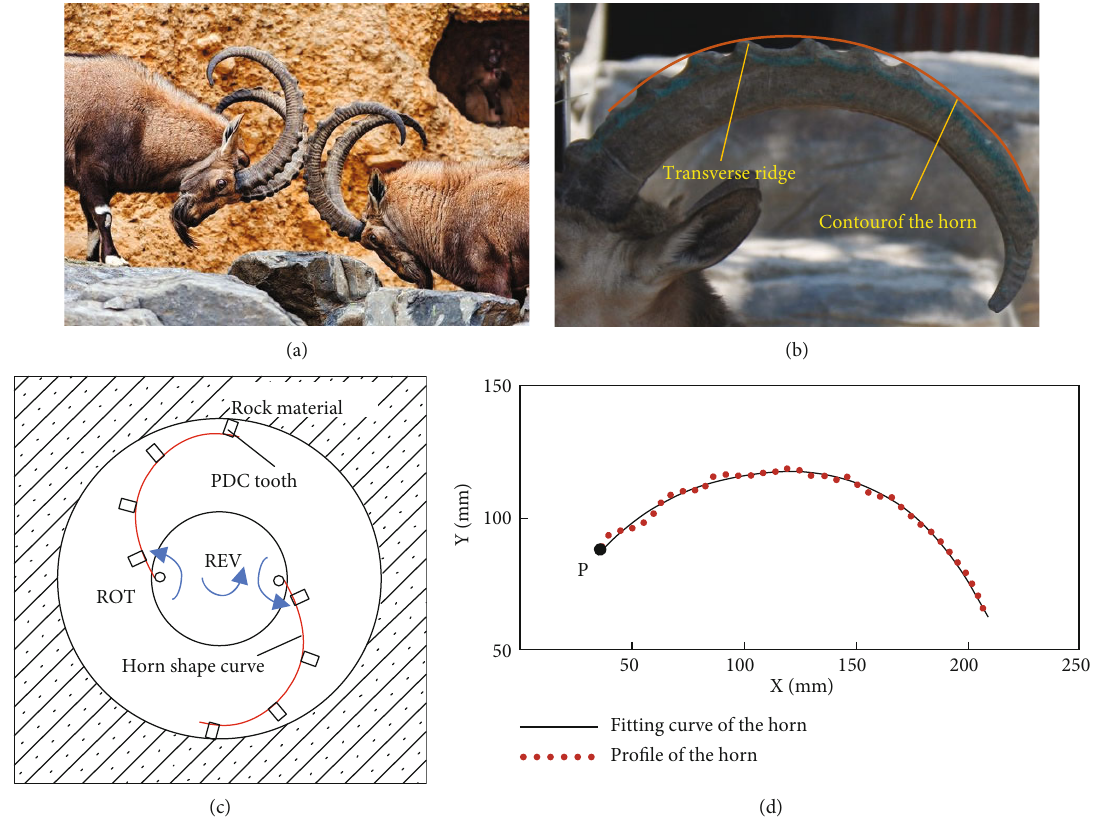
Figure 1: (a) Picture of Capra sibirica . (b) Sideview image of horn. (c) Bionic reaming method. (d) Pro fi le and fi tting curve of the horn.